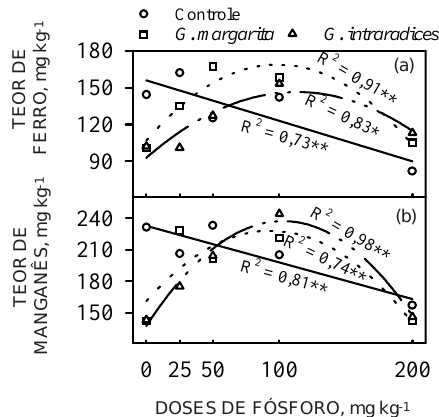
Figura 4. Teores de Fe (a) e Mn (b) nas vagens de plantas de soja inoculadas com fungos micor- rízicos arbusculares ( G. margarita ou G. intraradices ) ou não inoculadas (Controle), aos 90 dias do transplantio, considerando as doses de P. * Modelos matemáticos de regressão signifi- cativos a 5%; ** = significativos a 1% pelo teste